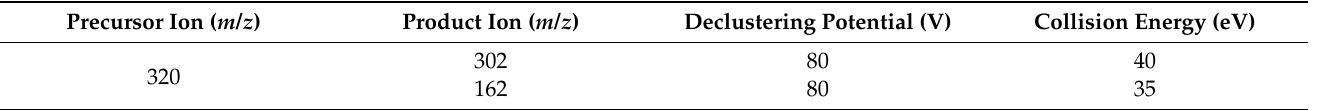
Table 3. Mass spectral parameters of